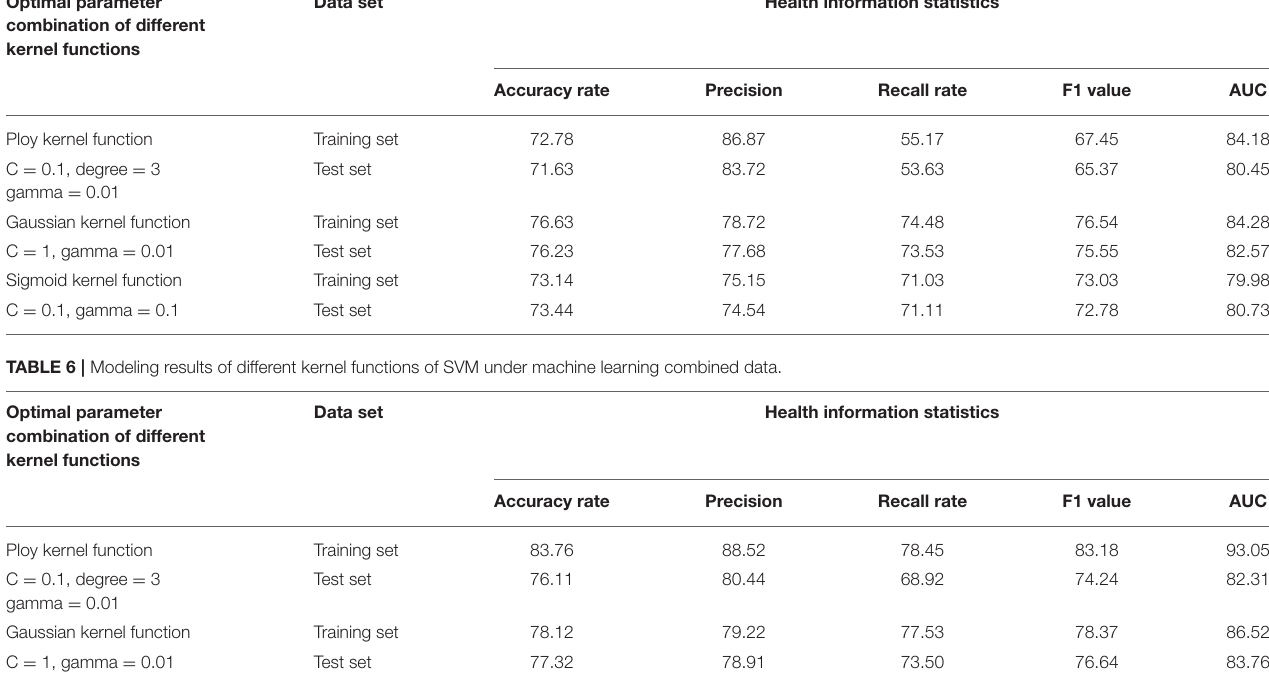
TABLE 5 | Optimal parameter combination of different kernel functions modeling results of machine learning basic data and health information statistics. Optimal parameter combination of different kernel functions